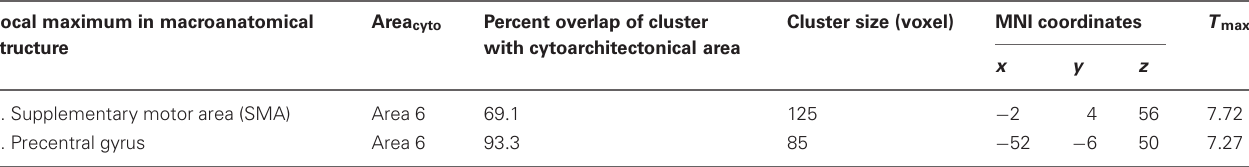
Table 2 | Macroanatomical structure, cytoarchitectonical area (Area cyto ), percent overlap of cluster with cytoarchitectonical area, cluster size in voxel, MNI coordinates ( x , y , z ), and maximum T value ( T max ) of the local maxima of the conjunction: functional localizer task (finger tapping > rest) ∩ experimental tasks ([CC + AA] >